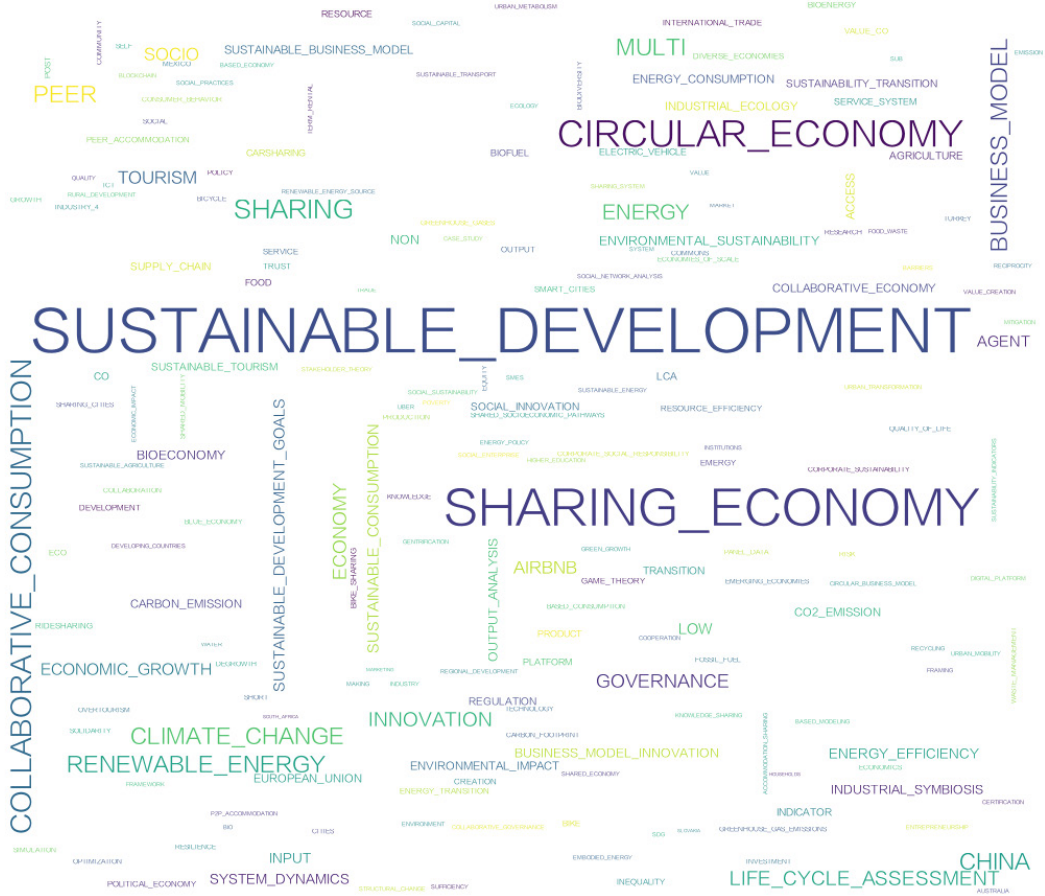
Figure 7. Word cloud map of the keywords on sustainable development in the sharing